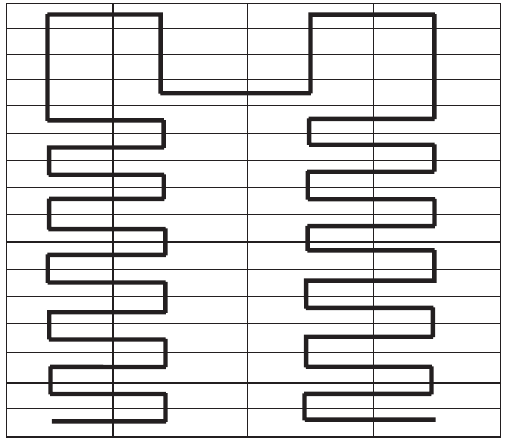
Figure 2.10. Next iteration when started with method